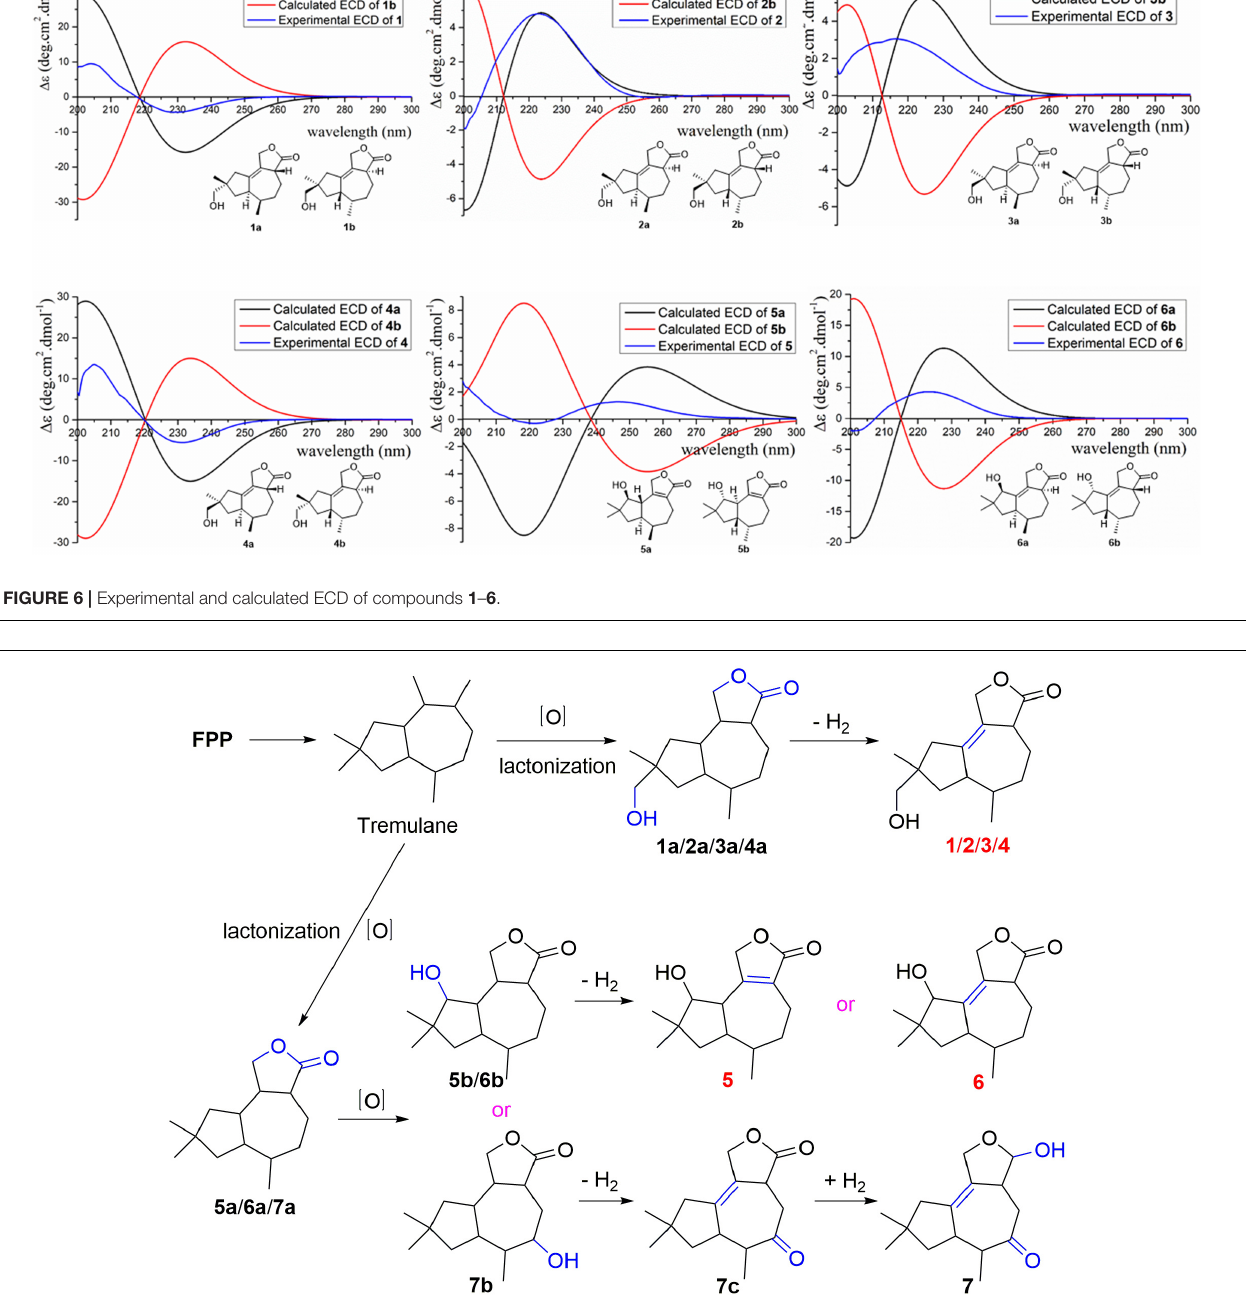
FIGURE 7 | Proposed biosynthetic pathway for 1 – 7